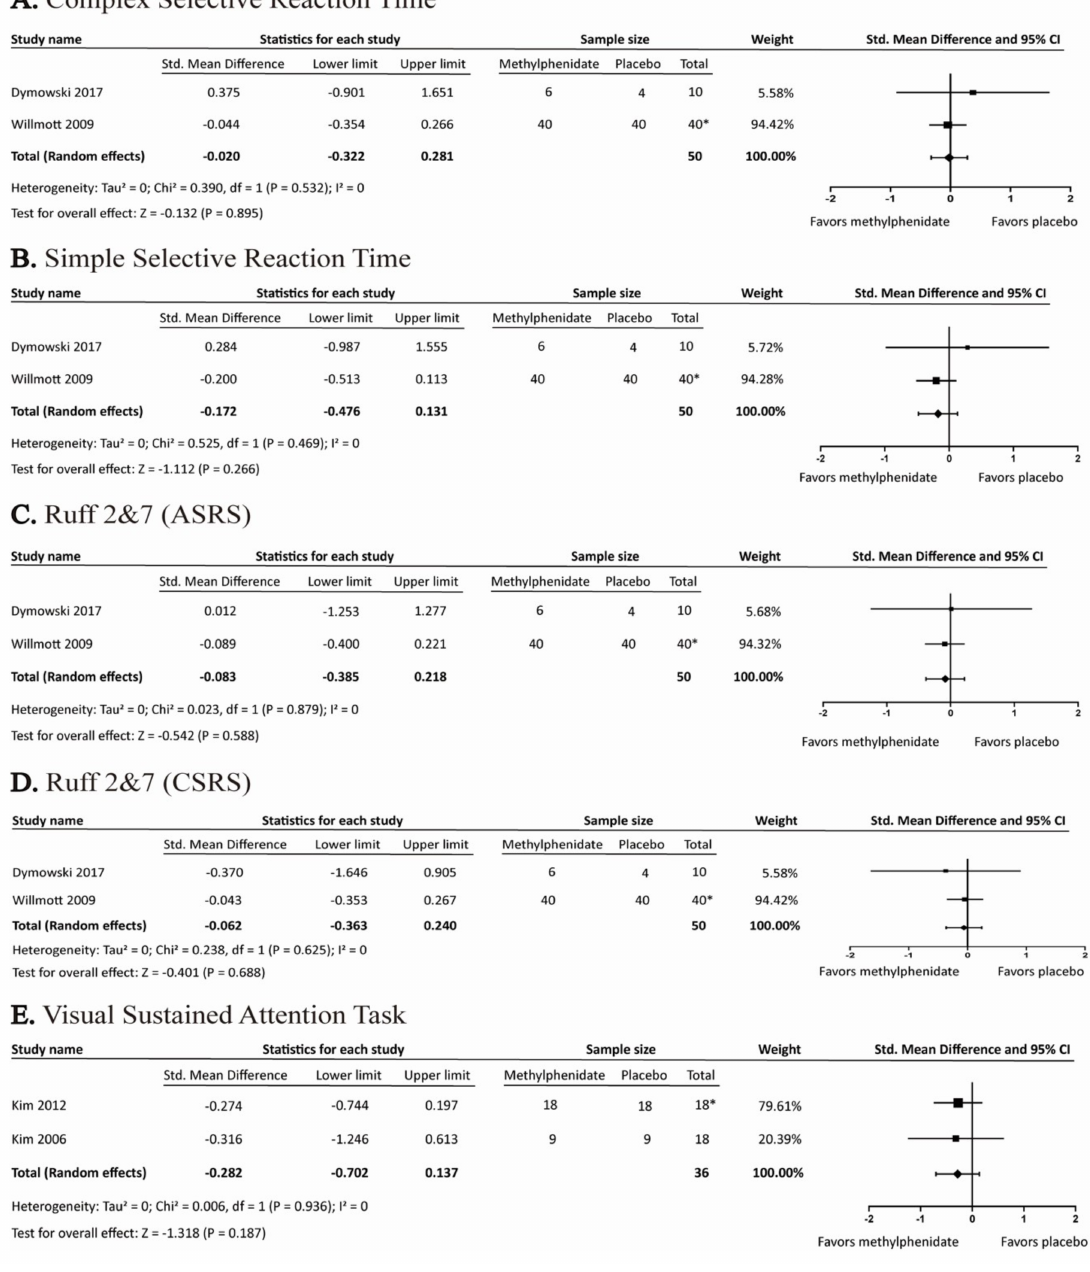
Figure 6. Forest plot of the e ff ects of methylphenidate on attention-related cognitive tests. *: crossover